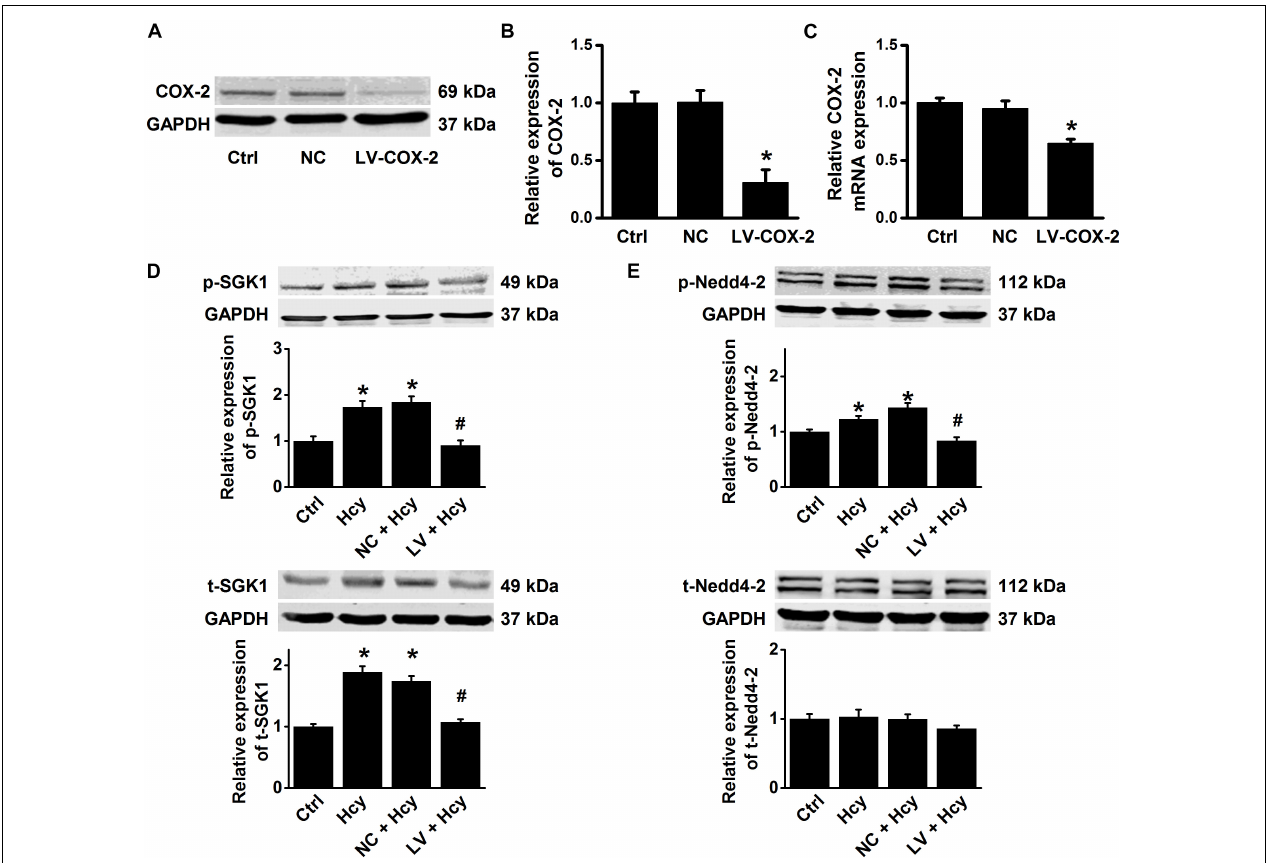
FIGURE 8 | COX-2 gene silencing attenuates Hcy-induced activation of SGK1/Nedd4-2 signaling in HUVECs. (A) Representative Western blots demonstrating COX-2 expression in HUVECs under the conditions of control, or transiently transfected with either COX-2 control LV or COX-2 shRNA LV (MOI = 10). (B) Summary plots of Western blots, showing the expression levels under each indicated condition. Data are means ± SEM of six experiments in each group. * P < 0.05 vs. ctrl. (C) Quantification of the results obtained from Real-time PCR analysis demonstrating the levels of COX-2 mRNA expression in HUVECs under each indicated condition. Data are means ± SEM of six experiments in each group. * P < 0.05 vs. ctrl. (D) Representative Western blots and summarized plots demonstrating the effects of Hcy (100 µ M for 6 h) on the expression levels of p-SGK1 (upper panels) and t-SGK1 (lower panels) in control HUVECs, or in HUVECs transfected with either shRNA against COX-2 or scramble shRNA. (E) Representative Western blots and summarized plots demonstrating the effects of Hcy (100 µ M for 6 h) on the expression levels of p-Nedd4-2 (upper panels) and t-Nedd4-2 (lower panels) in control HUVECs, or in HUVECs transfected with either shRNA against COX-2 or scramble shRNA. Data are means ± SEM of six experiments in each group. * P < 0.05 vs. ctrl; # P < 0.05 vs.